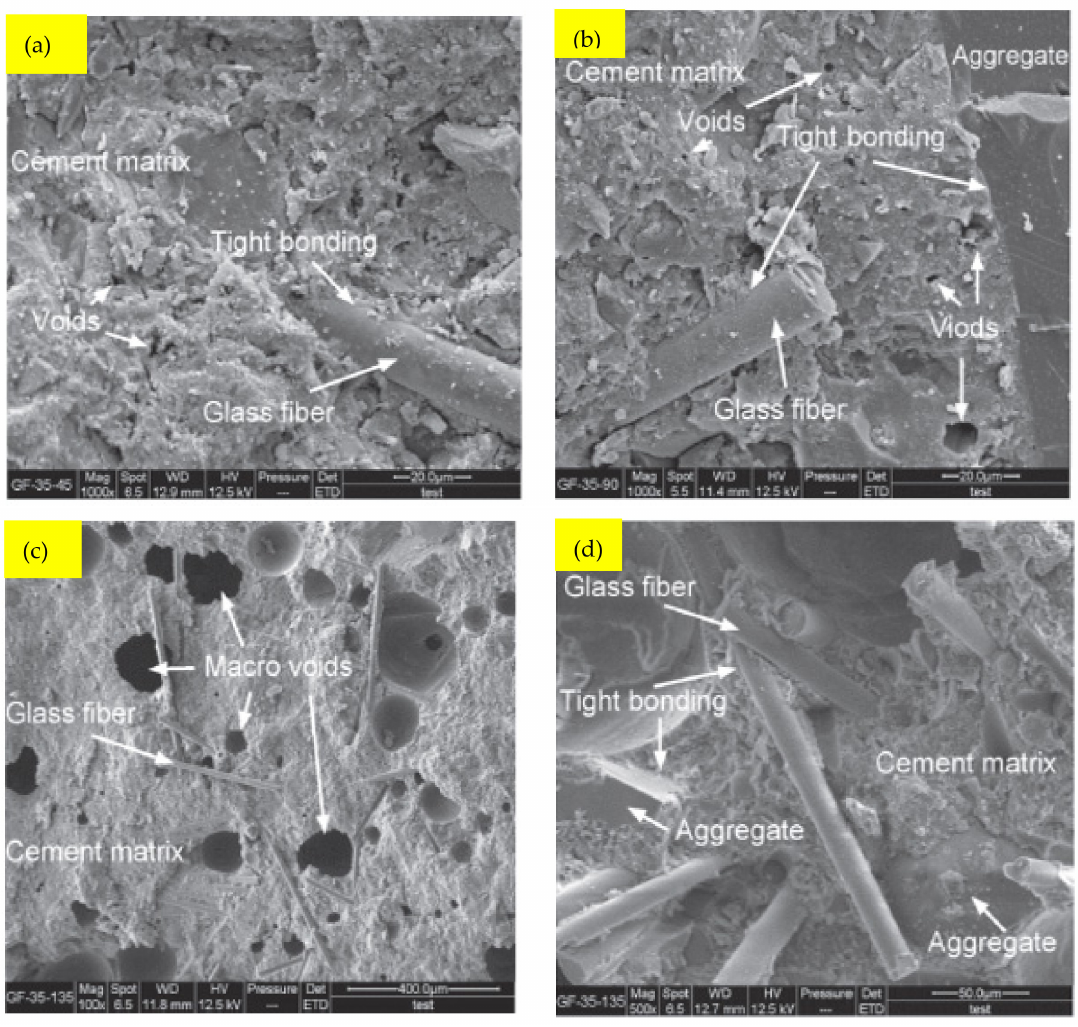
Figure 15. SEM Results of GF at Water to Binder Ratio 0.35: Used with the Permission of Elsevier